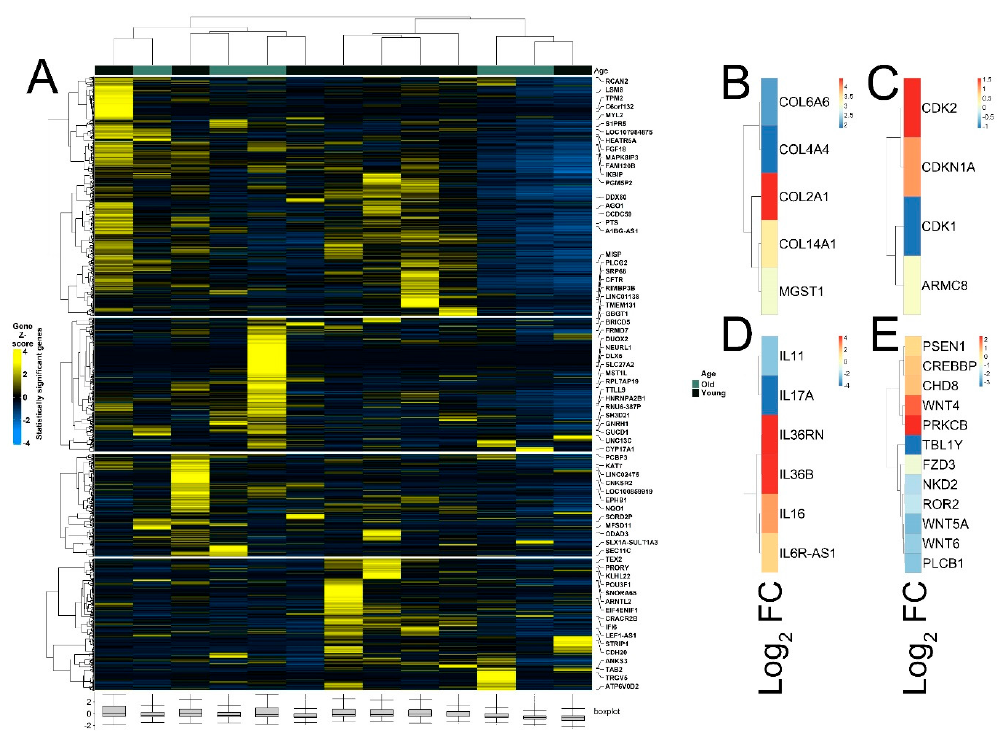
Figure 3. Heatmaps of differently expressed genes between young and old patient cohorts. ( A ) Hi- erarchical clustering heatmap of Gene Z score showing significantly differentially expressed genes between young and old age groups. ( B ) Differential expression of MGST1 and collagen genes. ( C ) Differential expression of cell proliferation genes. ( D ) Differential expression of interleukin genes. ( E ) Differential expression of genes of Wnt signaling pathway.